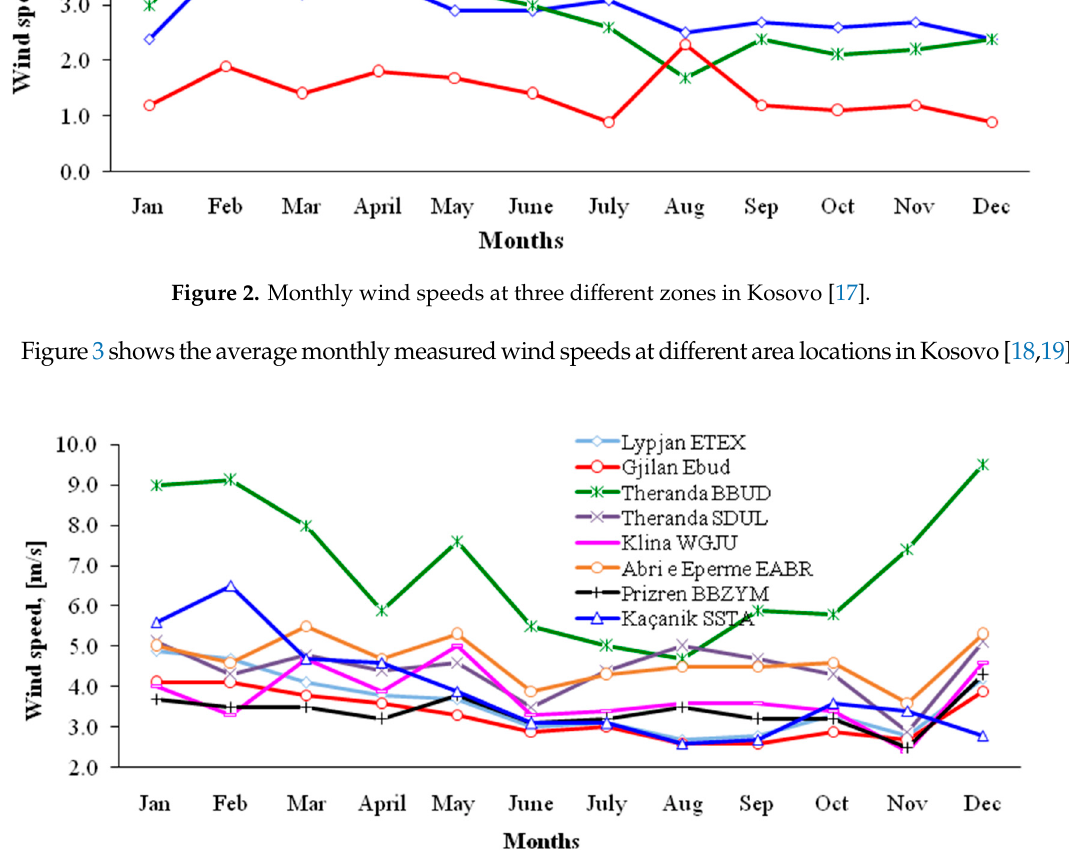
Figure 3. Average monthly measured wind speeds at different area locations in Kosovo [18,19].